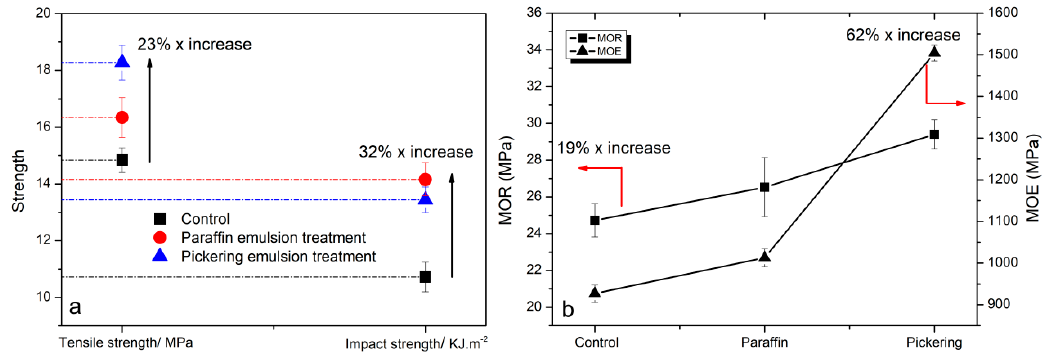
Figure 8. Mechanical properties of untreated (control) and emulsion treated WF/HDPE composites ( a ) tensile strength (TS) and impact strength (IS); ( b ) modulus of rupture (MOR) and modulus of elasticity (MOE).